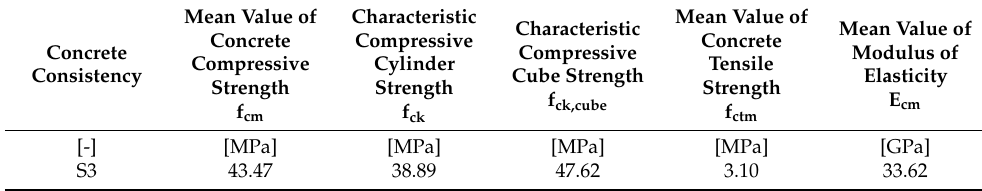
Table 3. Test results of selected concrete parameters.